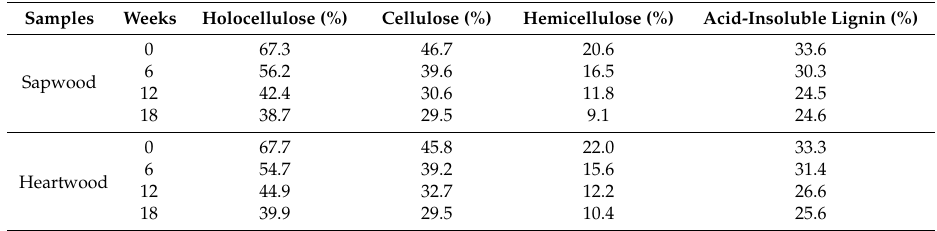
Chemical compositions of Chinese fir in progressive stages of decay caused by Trametes versicolor (L.) Lloyd (based on the oven-dried weight of the original untreated wood).